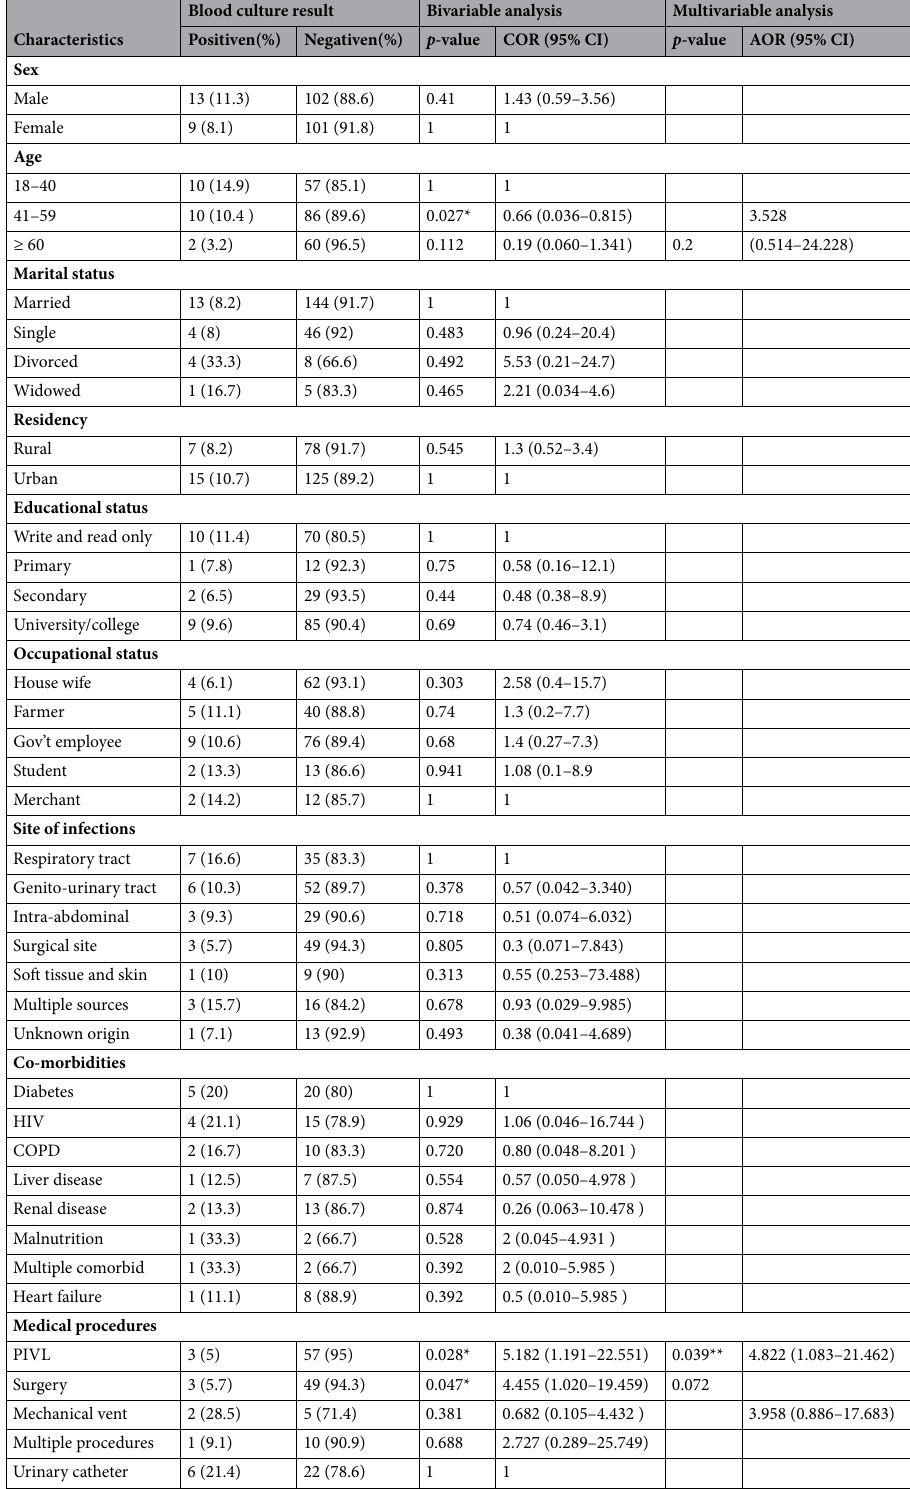
Table 5. Bivariable and multivariable logistic regression analyses of factors associated with BSI among suspected patients at AMGH, southern Ethiopia, 2020. *Statistically significant at p < 0.05 in bivariable analysis, **Statistically significant at p < 0.05, AOR: Adjusted odds ratio, COR: Crude odds ratio, 1: reference group, CI: Confidence interval. PIVL: Peripheral intravenous line, COPD: Chronic obstructive pulmonary disease, HIV: Human Immunodeficiency